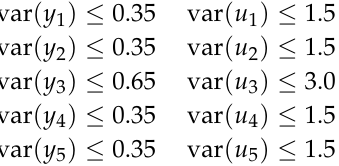
(cid:113) n (cid:107) ˆ u i (cid:107) ∑ r A A − 1 ˆ v i < 1 (Equation (41)) for D1 and D3; ˆ v T 1 ˆ σ i i i i = 1